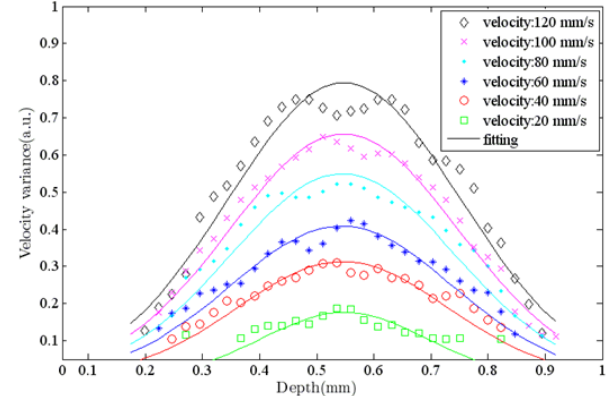
Figure 8. The velocity profile in the depth direction in the center of ODT